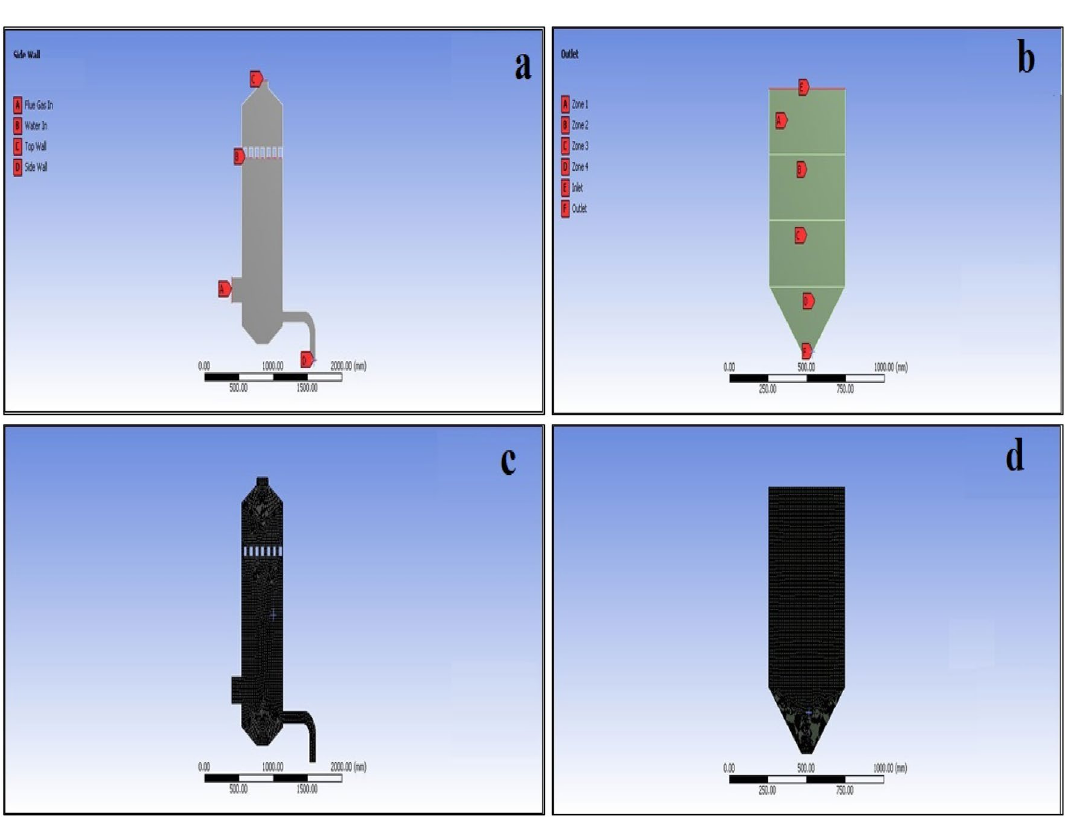
Figure 2. ( a ) Wet scrubber model with secondary water pollution connections, ( b ) filtration tank with sand filtrations zone, ( c ) meshed wet scrubber model, ( d ) meshed filtration tank